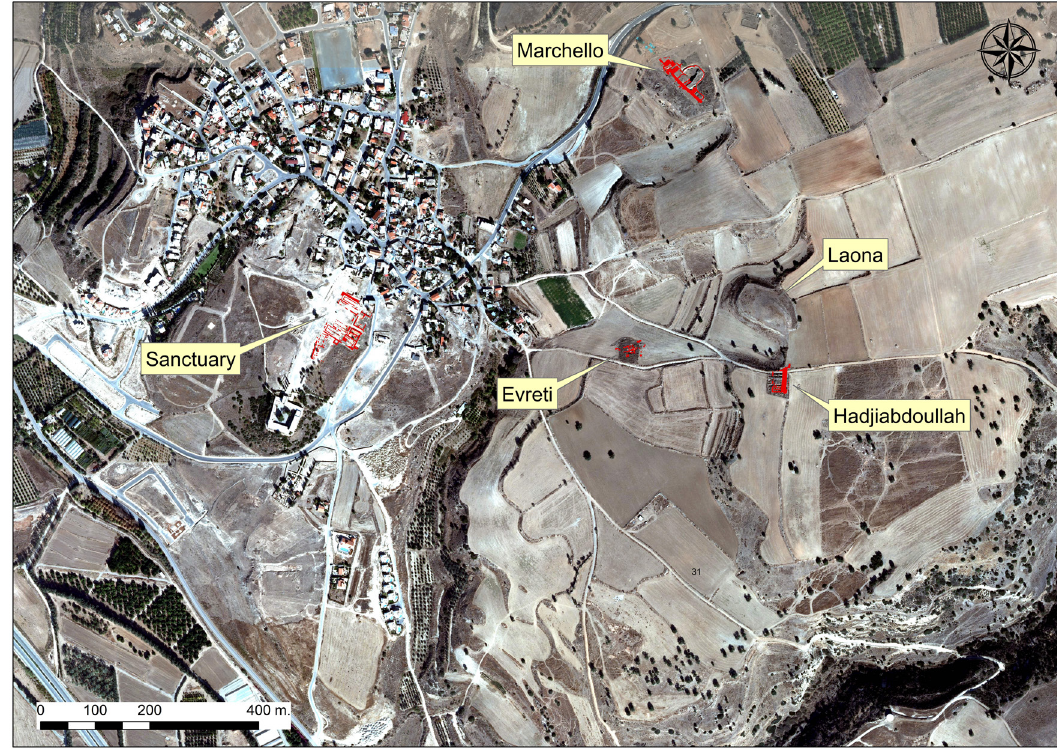
Figure 6. Visible monuments of the Palaepaphos urban landscape. Background: aerial orthophoto of 2008; source: Depart- ment of Lands and Surveys, Cyprus. Drafted by A. Agapiou